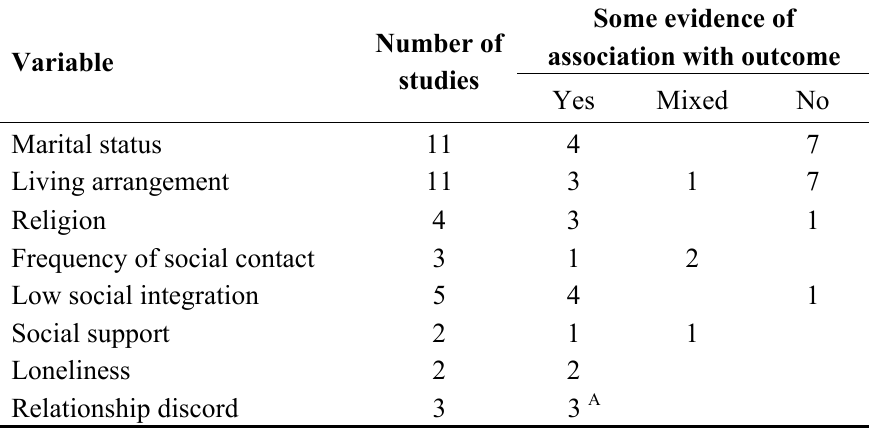
Table 2. Box score summary of review